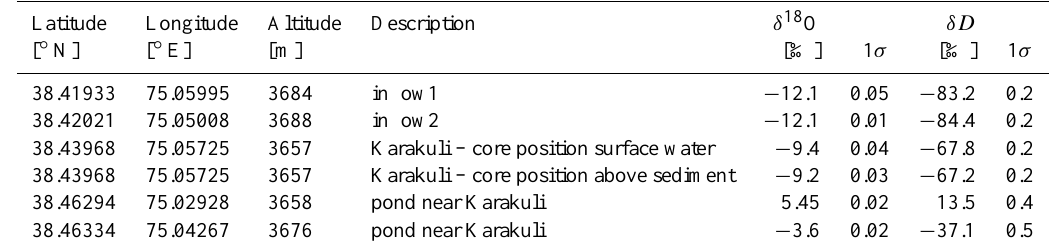
Table 1. δ 18 O and δD values of water samples collected in September 2008 at Lake Karakuli, its inflows and nearby ponds. Latitude Longitude Altitude